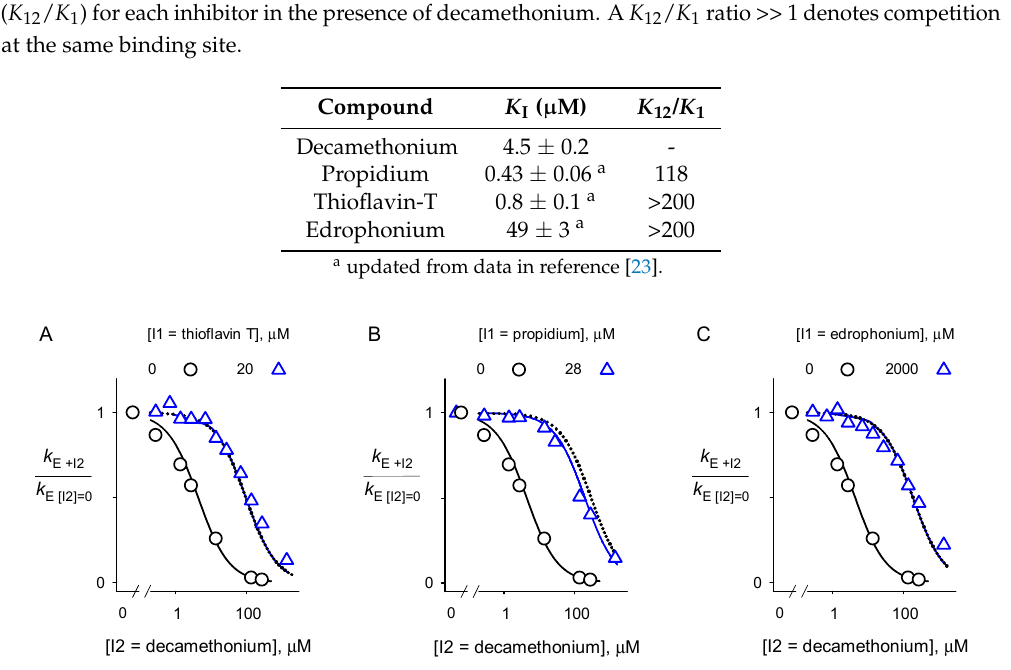
a updated from data in reference [23].